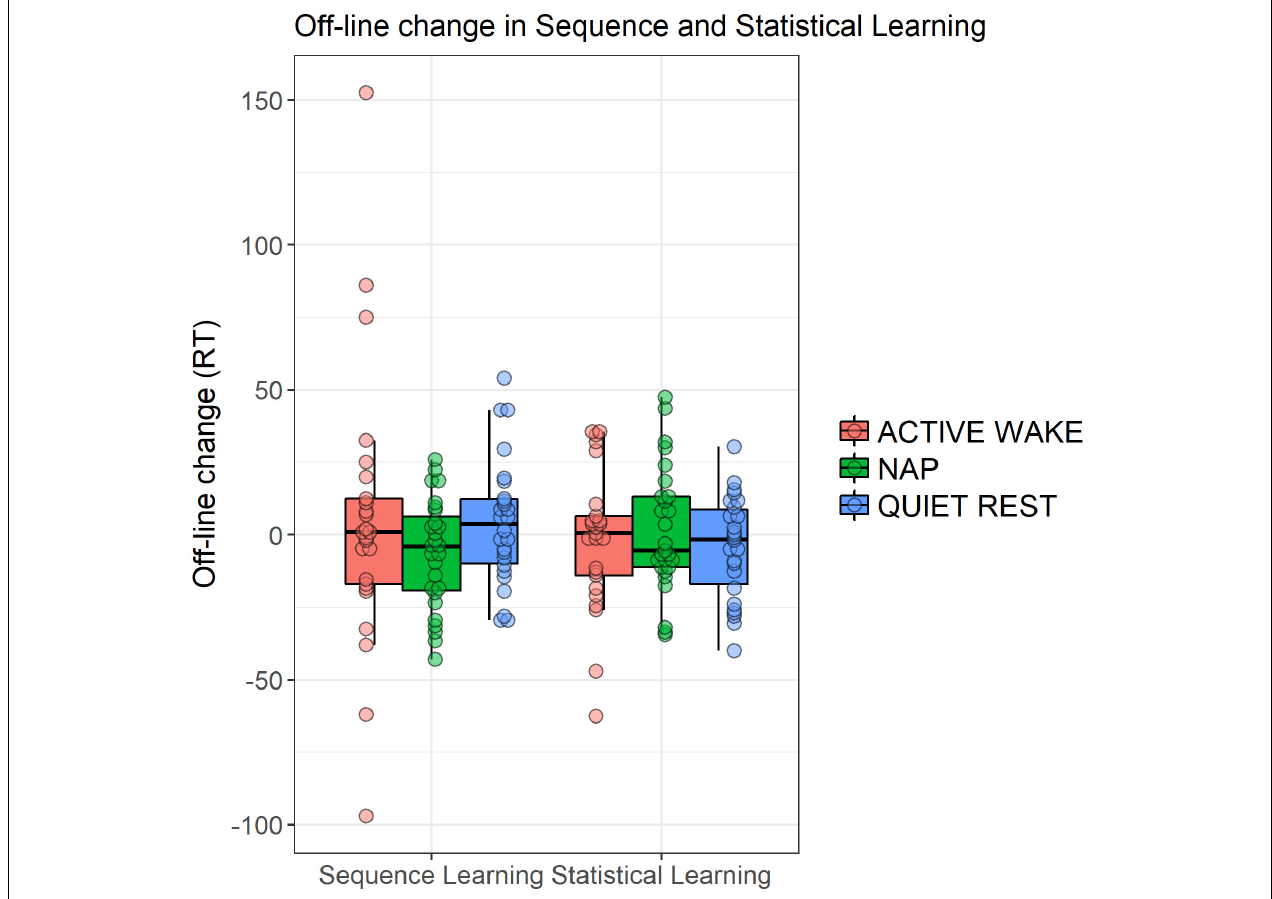
FIGURE 5 | Off-line changes in learning indices within the three groups. Off-line changes were calculated by the learning scores of the 7th epoch minus the respective learning scores of the 6th epoch. Dots show individual data points, the vertical line within the boxes show the medians, boxes represent the first and third quartiles, whiskers indicate the interquartile range of